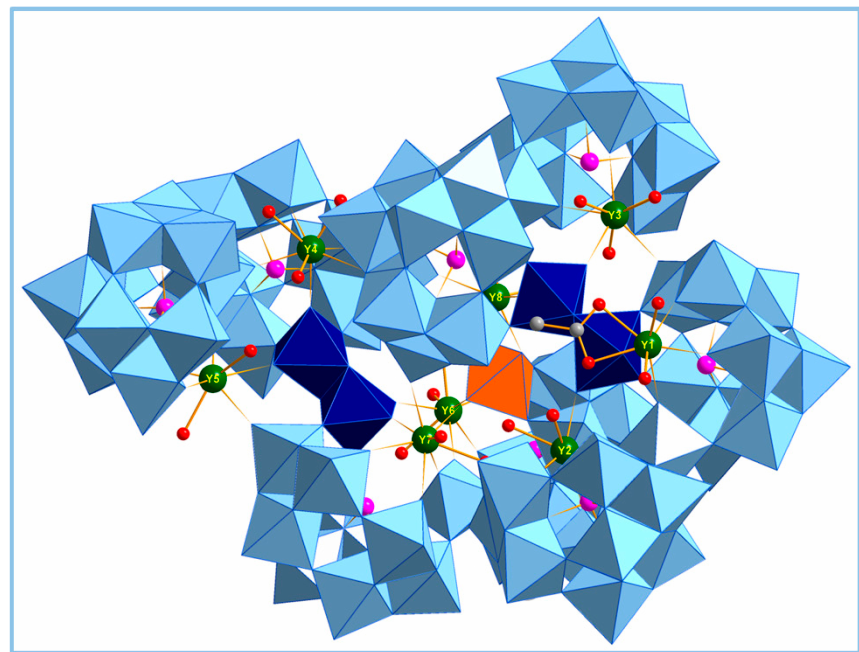
Figure 1. Combined polyhedral/ball-and-stick representation of 1. Color code: WO 6 octahedra pale blue/dark blue/orange, As pink balls, Y green balls, O red balls, C grey balls.